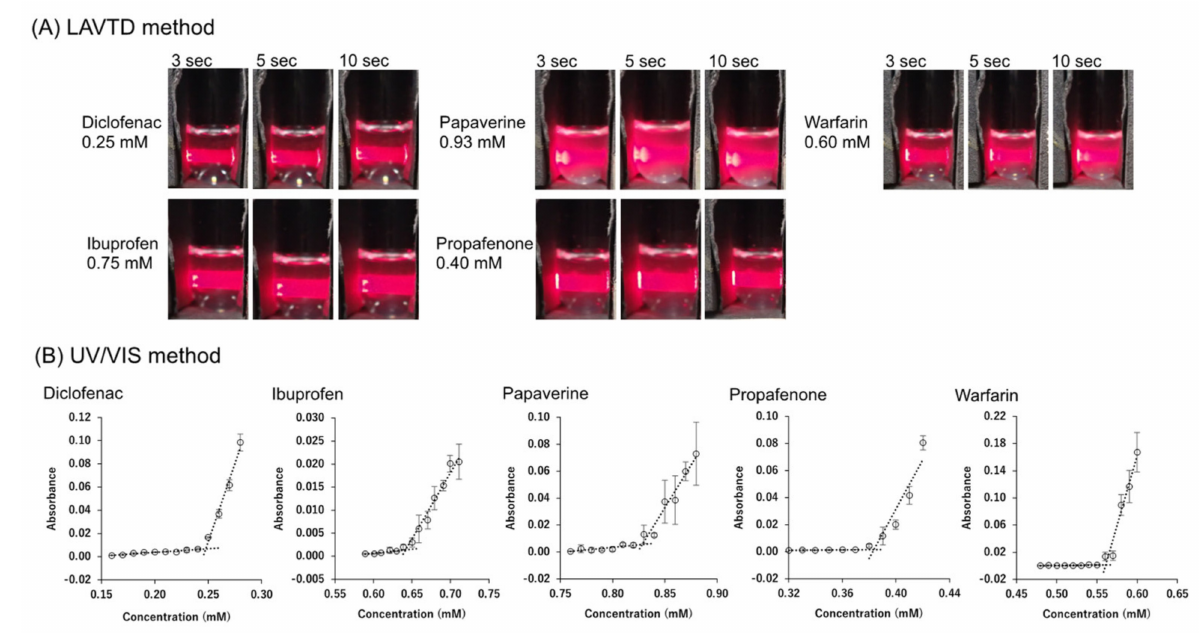
Figure 2. ( A ) The photograph of LAVTD method at 298 K. ( B ) Concentration vs. absorbance profiles in S LLPS measurement by turbidity detection by UV/VIS spectroscopy at 298 K. The S LLPS 0 determined as the concentration intercept value.